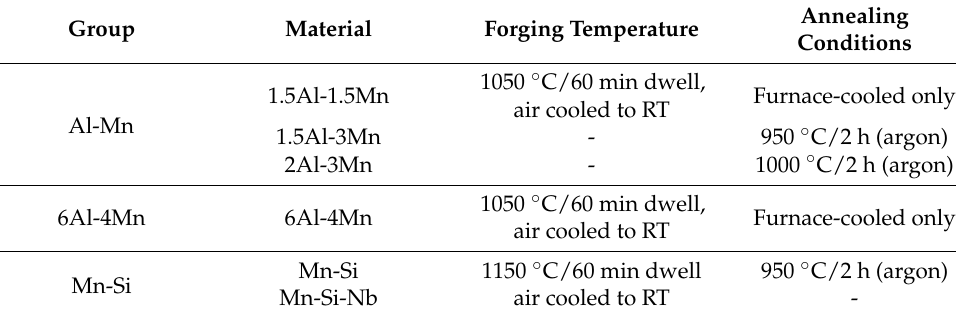
Table 2. Experimental steels—forging and annealing